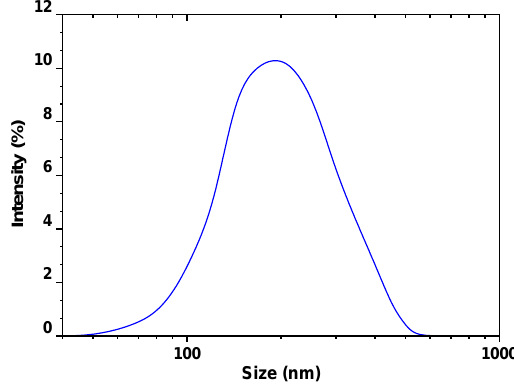
Figure 2. Size distribution of the the prepared nanocomposite.